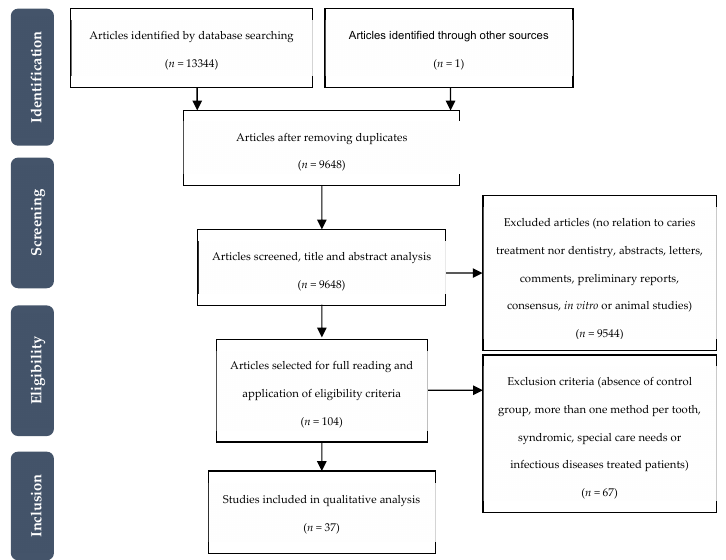
Figure 1. Flowchart of the studies selection process.